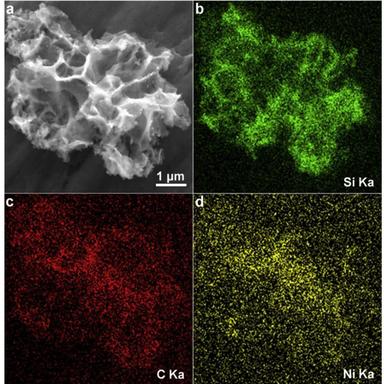
The element mapping of selected area of MP-Si/Ni/C composite (a), Si (b), C (c), and Ni (d).